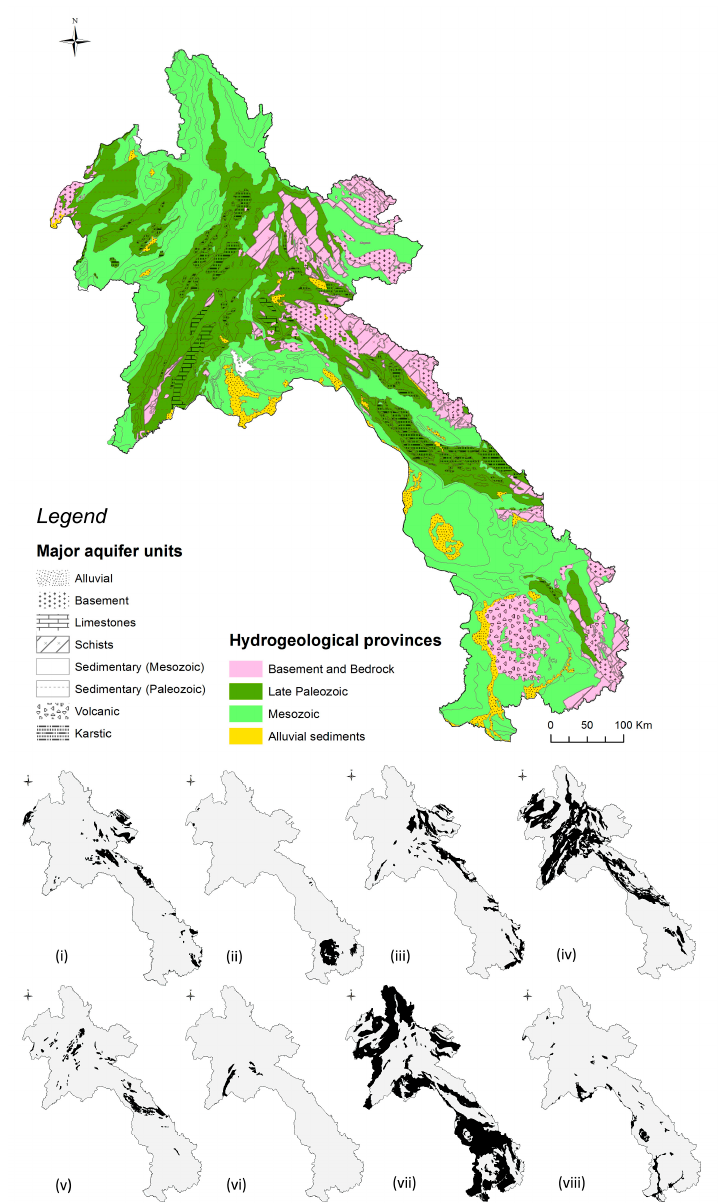
Figure 3. Synthetic map of the four MRC hydrogeological groups (greyscale filling) and the eight identified aquifer units (textures). Sub-maps present the spatial repartition of the 8 aquifer units as (i) Basement aquifers, (ii) Volcanic aquifers, (iii) Schists, (iv) Paleozoic sedimentary, (v) Karsts, (vi) Limestones, (vii) Mesozoic sedimentary, and (viii) Alluvial sediments.